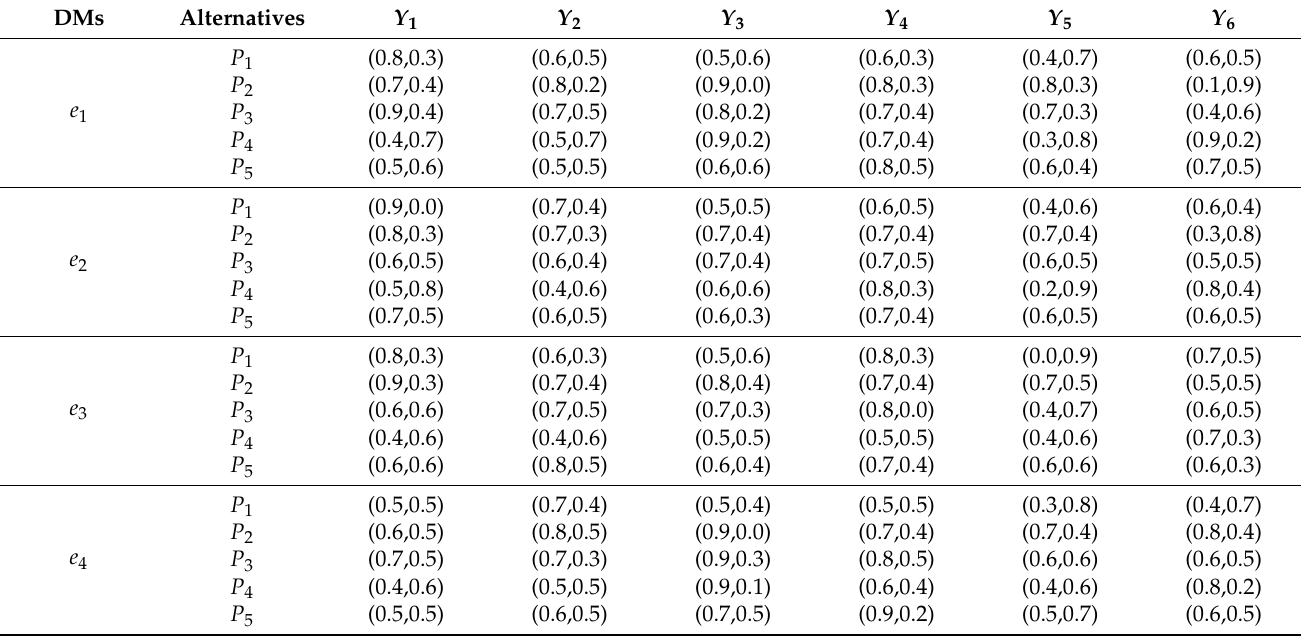
Table 3. Evaluation information of DMs on WCRCs.